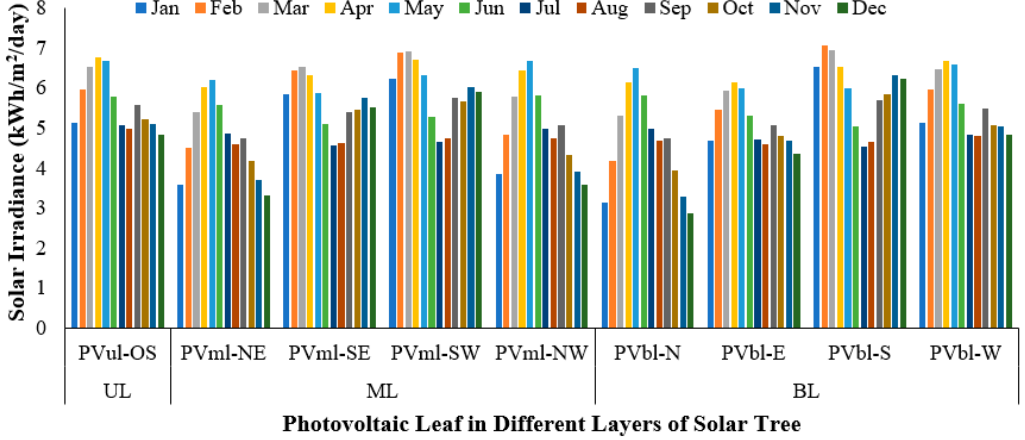
Figure 5. Incident solar irradiance on the photovoltaic leaves in the proposed three-layered SPVT (3-L SPVT) system. Data source: Indian Meteorological Department (IMD).